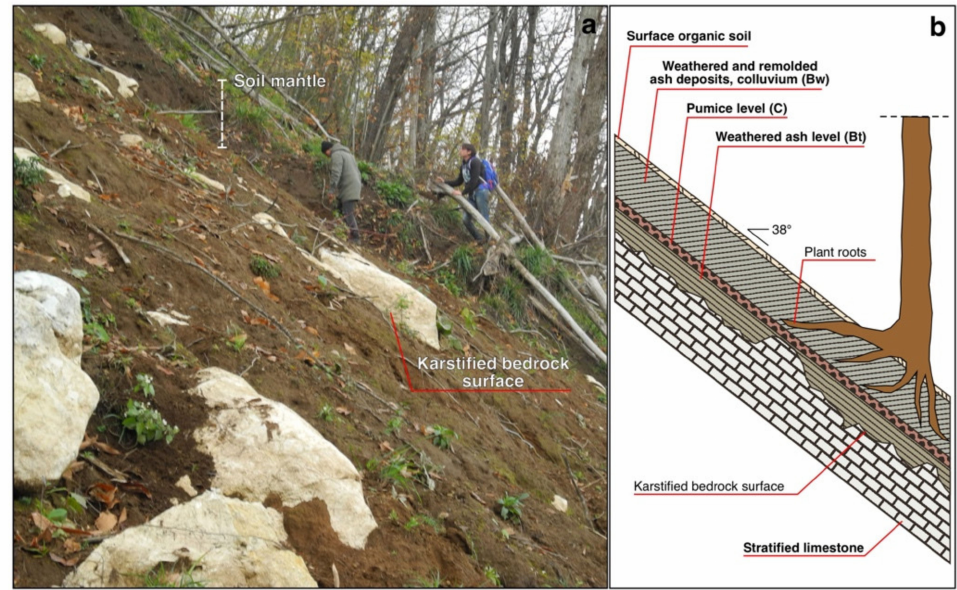
Figure 2. ( a ) Avalanche/erosion zone of the 21 December 2019 landslide and ( b ) schematic profile of a typical slope of the high-elevation zones of the Campania region (soil mantle thickness is exaggerated); modified from Reference